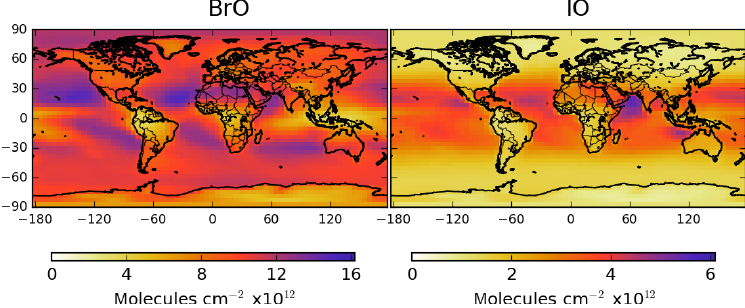
Figure 6. Annual mean integrated model tropospheric column for BrO and IO in moleculescm − 2